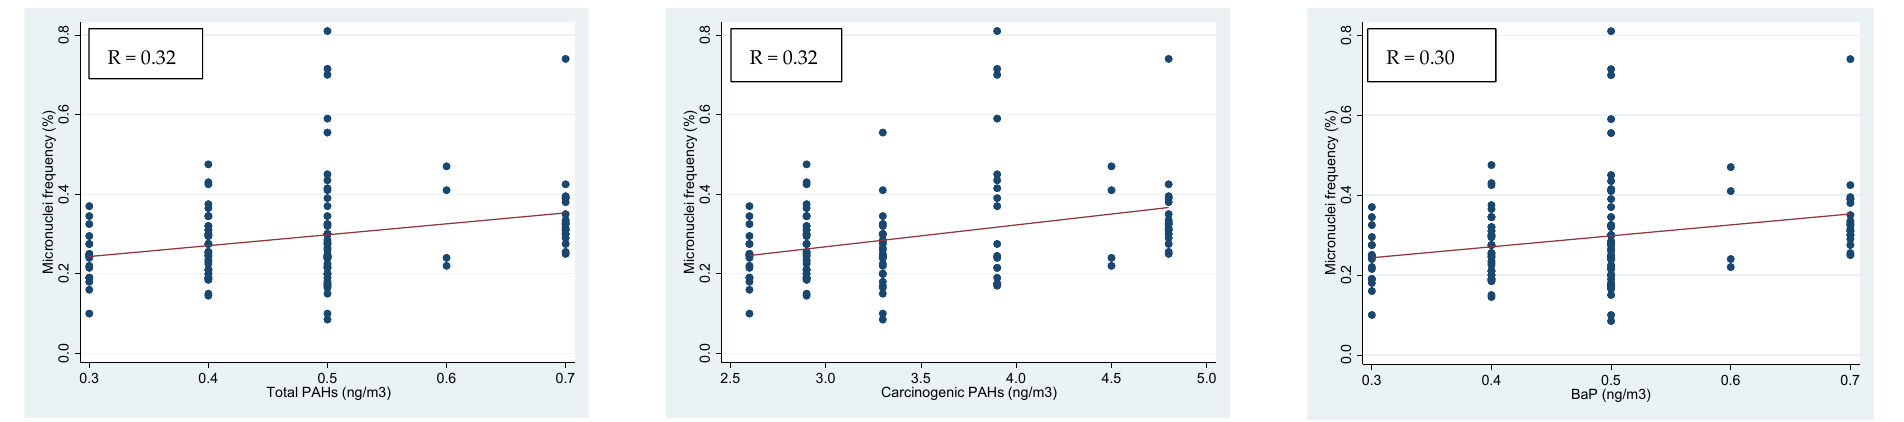
Figure 3. Linear regressions of micronuclei in children’s buccal cells on total PAHs, carcinogenic PAHs and BaP concentrations in PM 0.5 and the Spearman’s correlation coefficients.